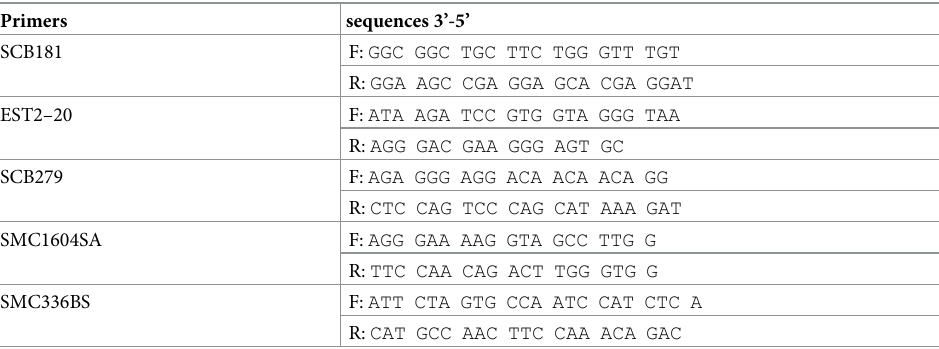
Table 2. Primers sequences for PCR in SSR